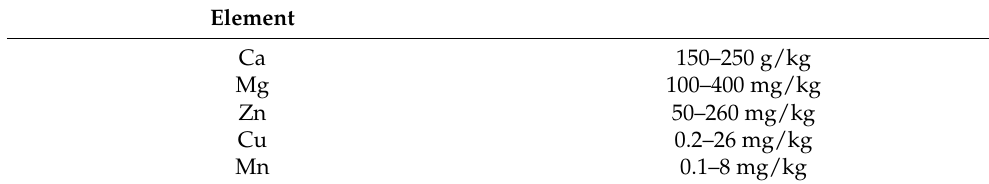
Table 1. Reported concentrations of selected elements in human bones [56] (values in mg/kg unless otherwise